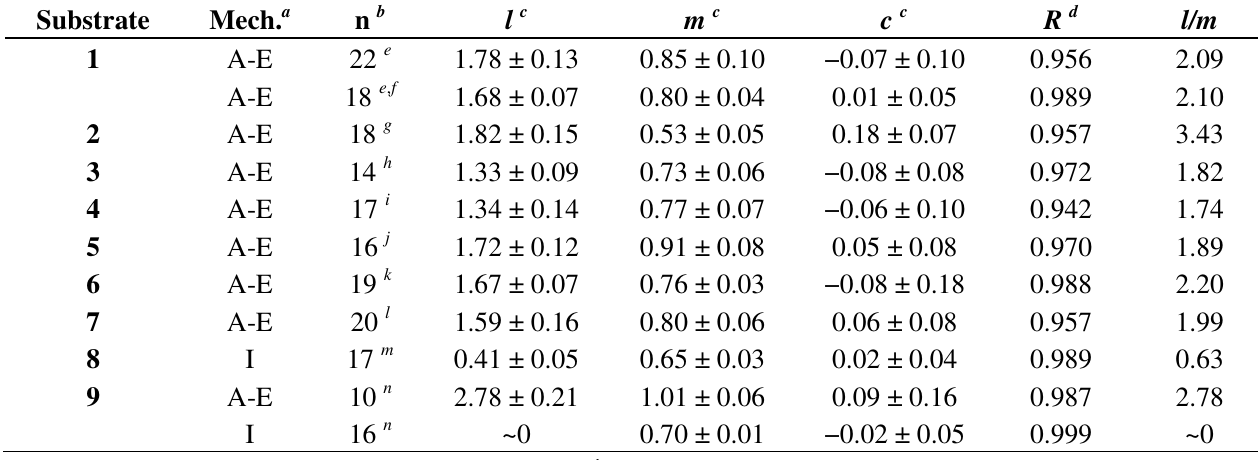
Table 3. Correlations of the specific rates of solvolysis of isobutyl fluoroformate ( 1 ) and a comparison with the corresponding values for the solvolyses of isobutyl chloroformate and other fluoroformates using the Grunwald-Winstein